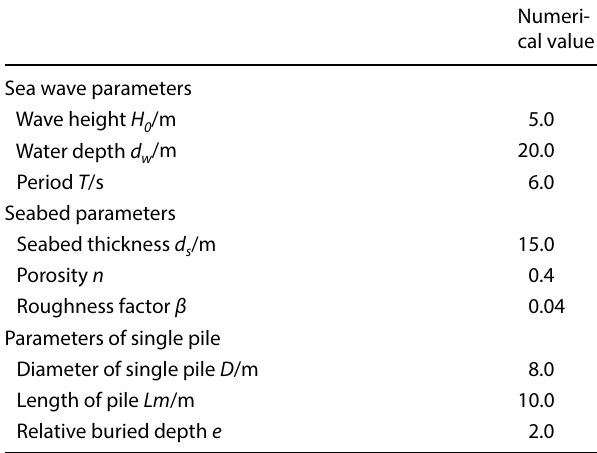
Table 1 Numerical analysis